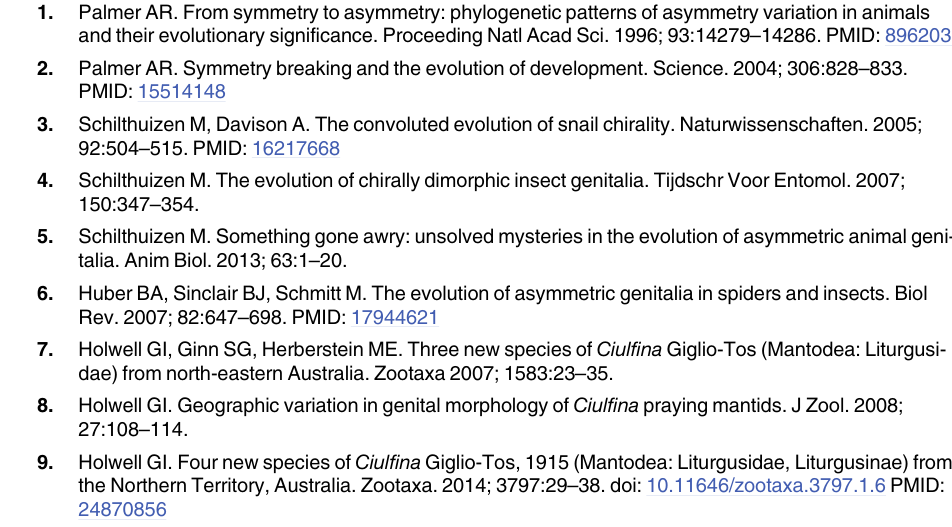
S1 Table. Raw data for all behavioural experiments (XLSX) S2 Table. Raw data for all morphological